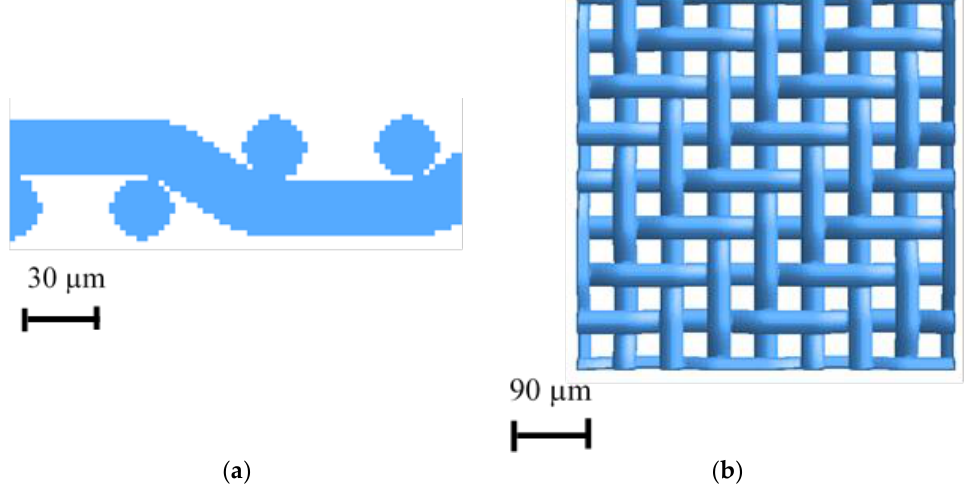
Figure 8. Computed wire cloth, ( a ) side view in a sectional plane through a wire, ( b ) top view of the complete model wire cloth structure.